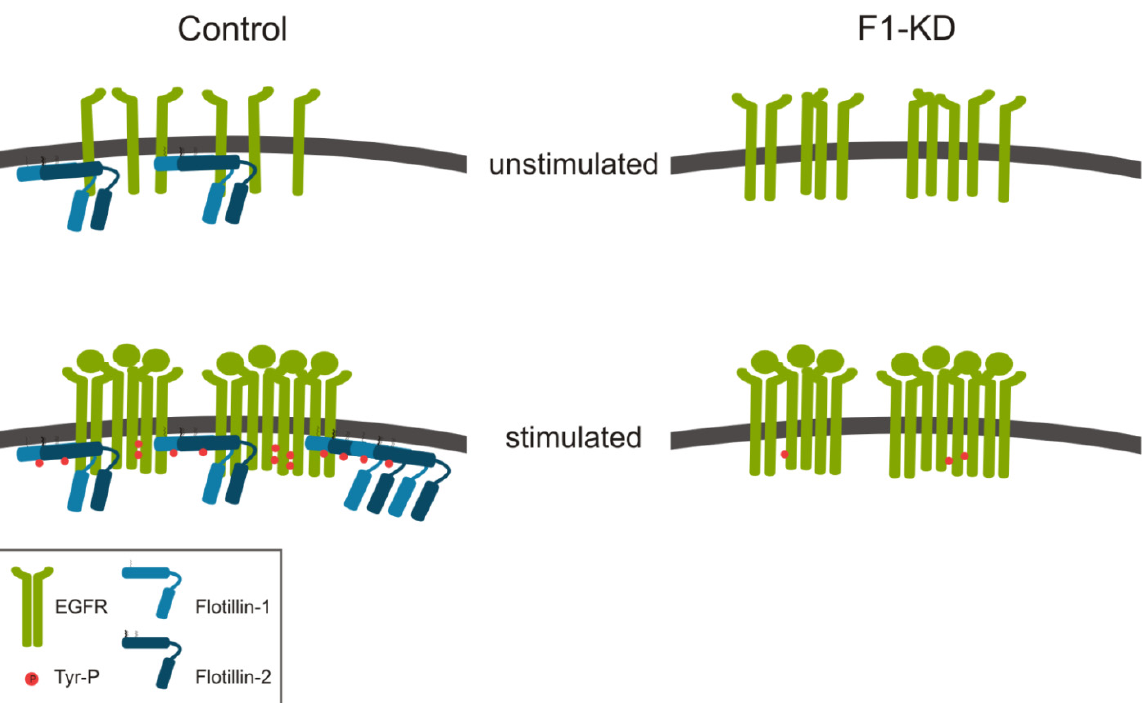
Figure 2. Flotillins in EGFR activation/clustering. While EGF stimulation of control cells induces EGFR activation, tyrosine phosphorylation and clustering of the receptor, cells depleted of flotillin-1 show a reduced tyrosine phosphorylation. Already in unstimulated cells, preformed EGFR clusters that do not increase in size upon EGF stimulation are observed in the absence of